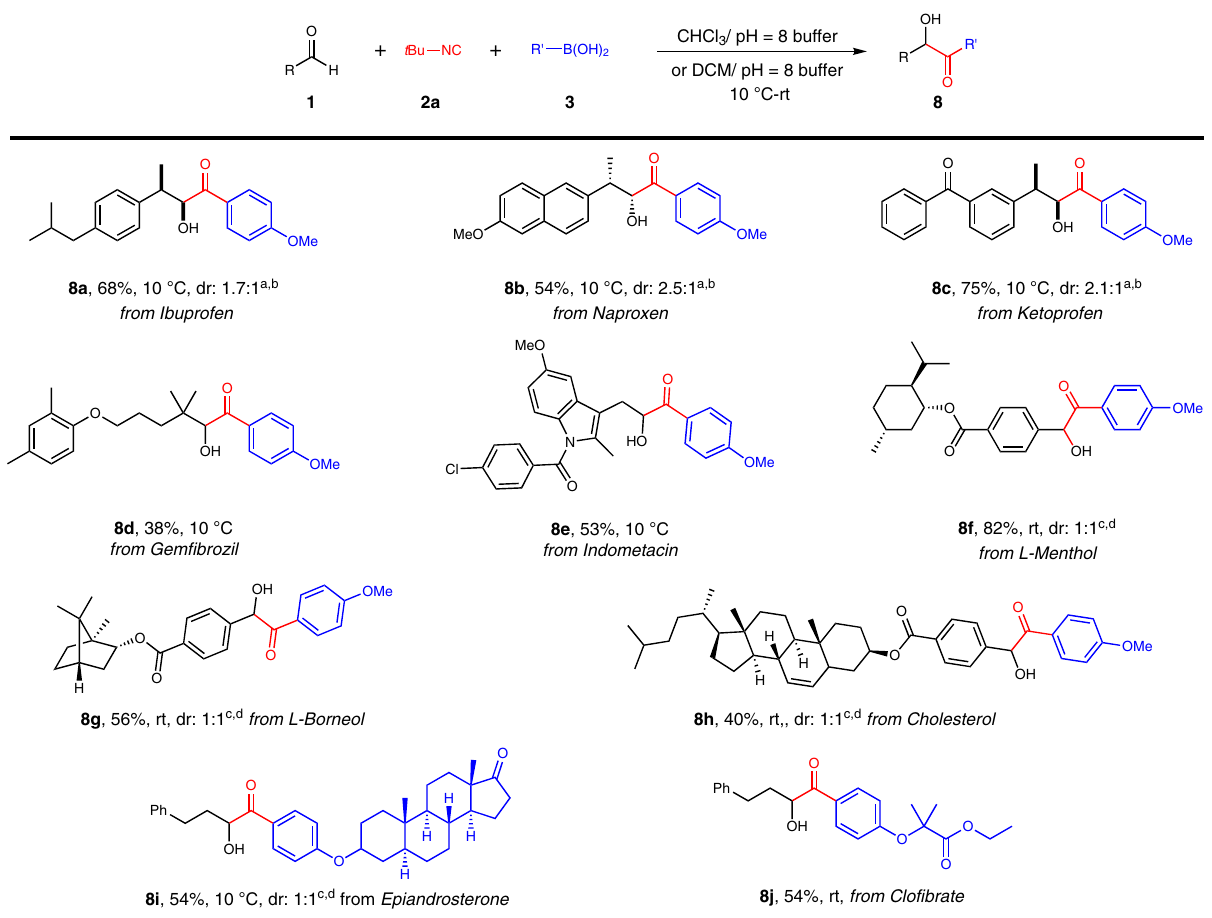
Fig. 5 Late-stage modi fi cations of bioactive or drug molecules. Reaction conditions: a 1a (0.2 mmol, 1 equiv), 2a (0.3 mmol), 3 (0.36 mmol), and CHCl 3 / pH = 8 buffer (7:3, 1 mL) under an argon atmosphere for 24 hours unless otherwise speci fi ed. b The dr was determined by 1 H NMR analysis. c 1 (0.2 mmol, 1 equiv), 2a (0.3 mmol), 3 (0.36mmol) and DCM/pH = 8 buffer (7:3, 1 mL) under an argon atmosphere for 24 hours. d The dr was determined by HPLC